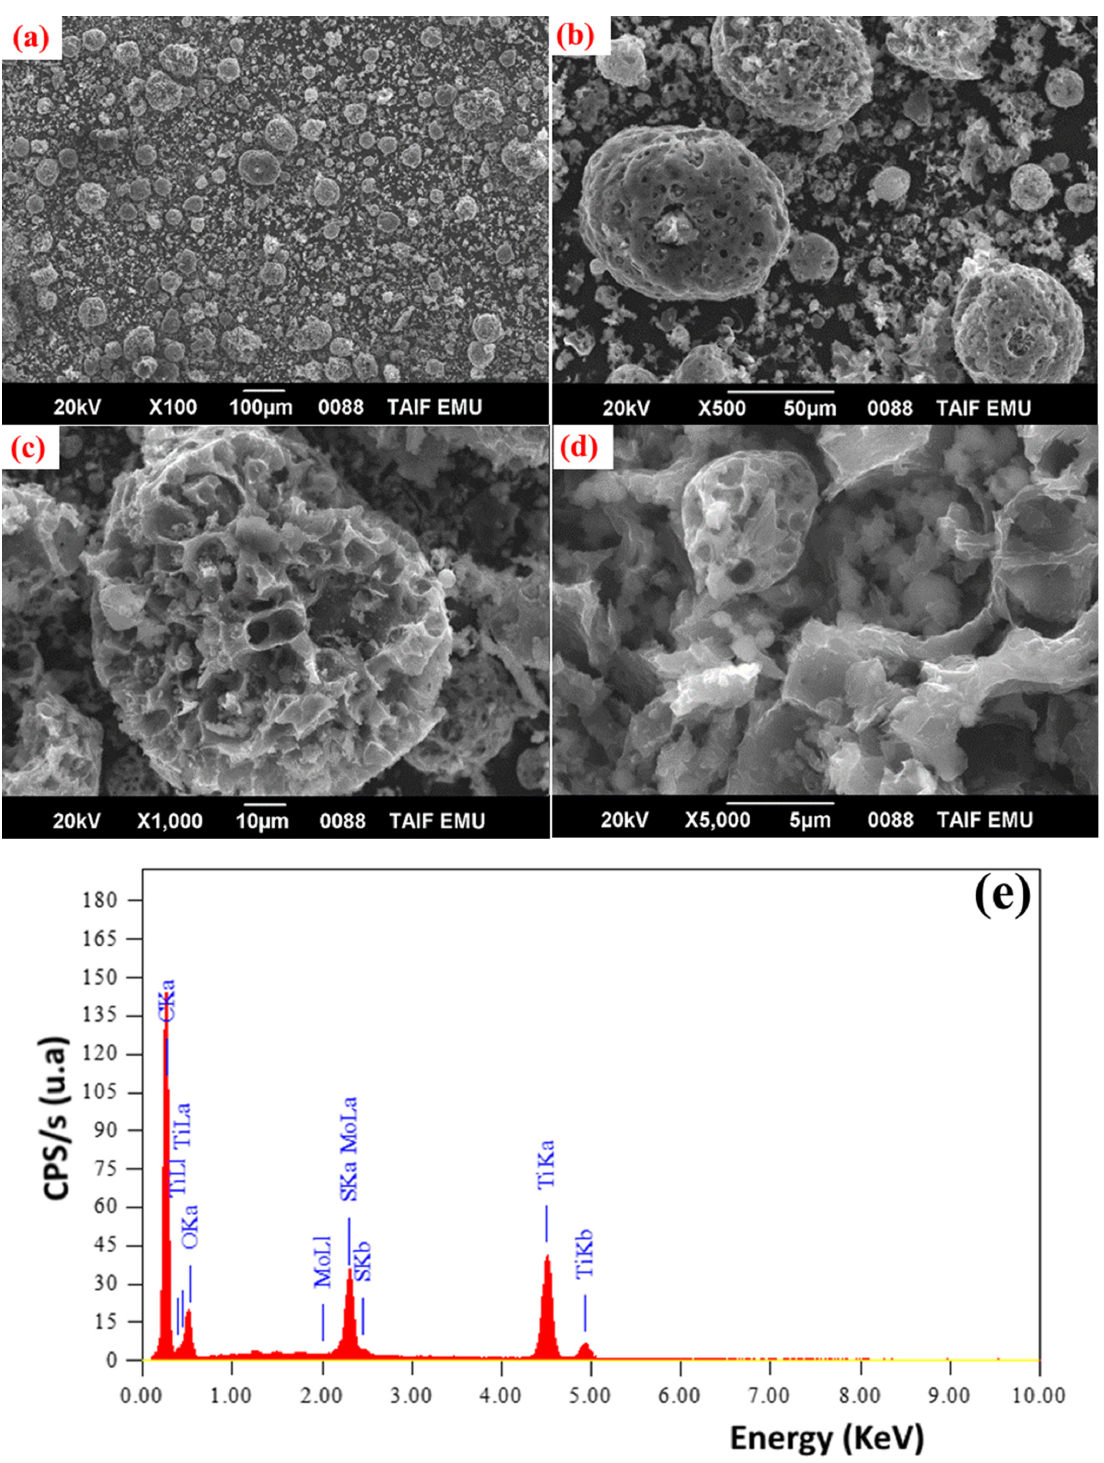
Figure 11. SEM images at different magnifications ( a – d ) and EDX spectrum ( e ) of the FA-TiO 2 cata- lyst after cathodic activation.